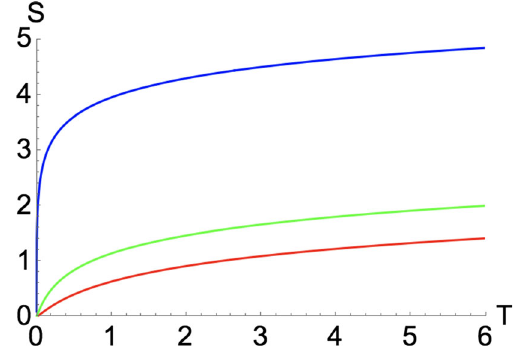
Fig. 3 Entropy (55), for a single δ – δ (cid:2) -potential as a function of T for the potential V δδ (cid:2) and the configurations w 0 = 0 . 01, w 1 = 2 (blue); w = 3, w = 2 (green) and w 0 1